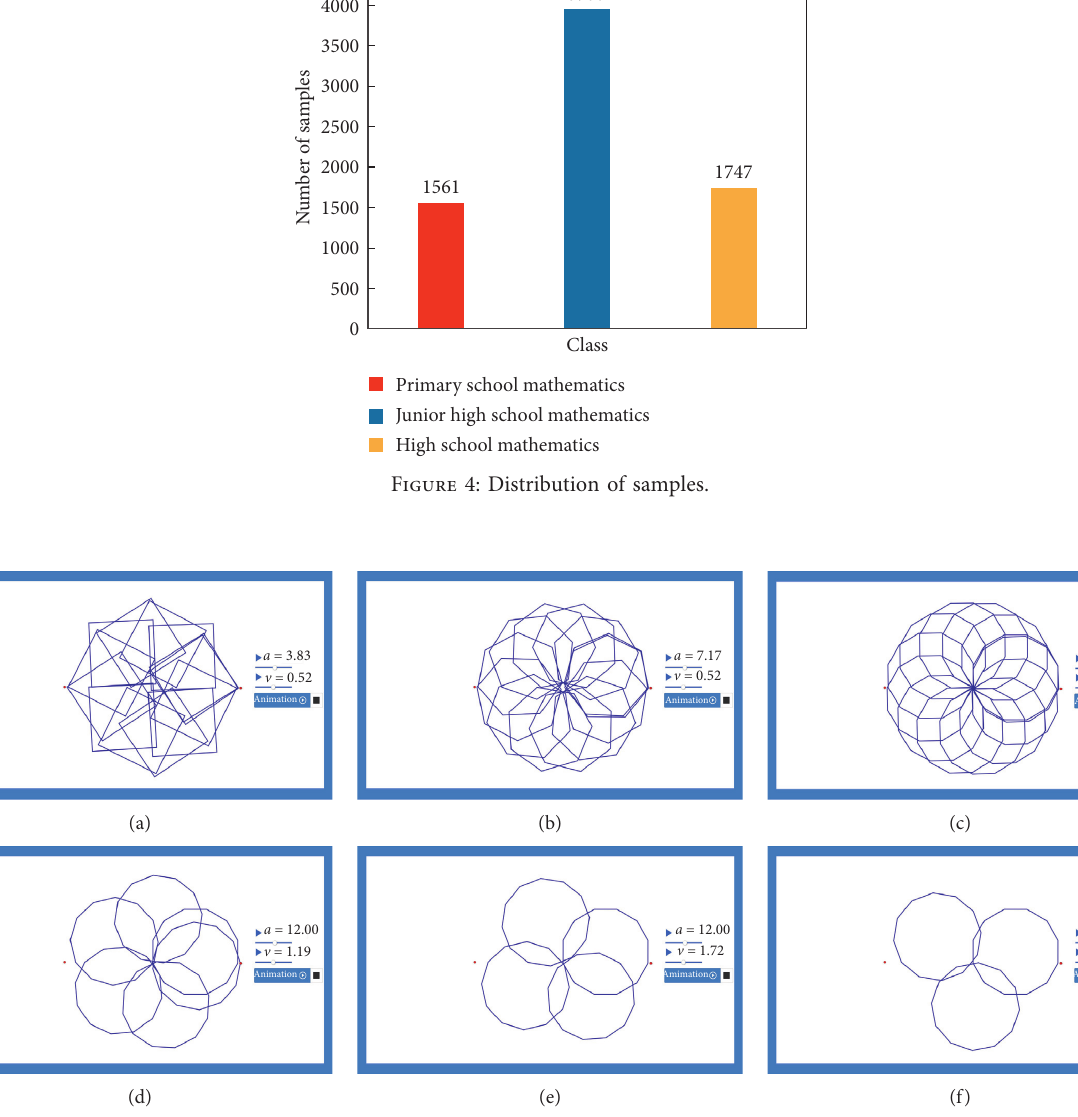
Figure 5: The picture preview of “iteration of regular polygon.” (a)–(c) Click the variable ruler a ; change the number of sides of the polygon. (d)–(f) Click the variable ruler v ; change the depth of the